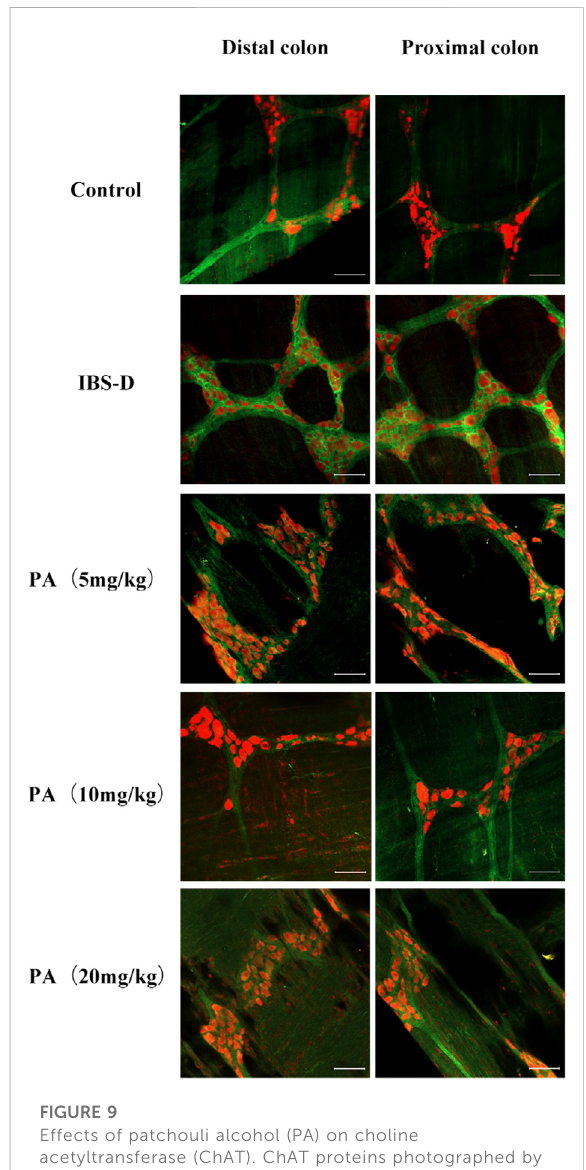
FIGURE 9 Effects of patchouli alcohol (PA) on choline acetyltransferase (ChAT). ChAT proteins photographed by laser confocal microscopy. Immuno fl uorescence results of ChAT positive neurons in the proximal and distal colon of PA groups. HuC/D (Red), ChAT (Green) Scale Bar = 50 μ